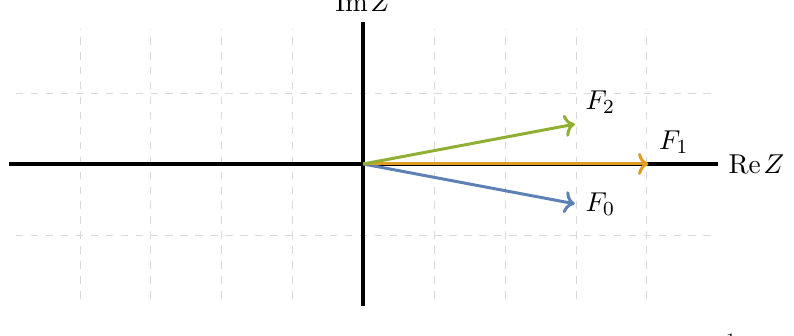
JHEP08(2017)063 6